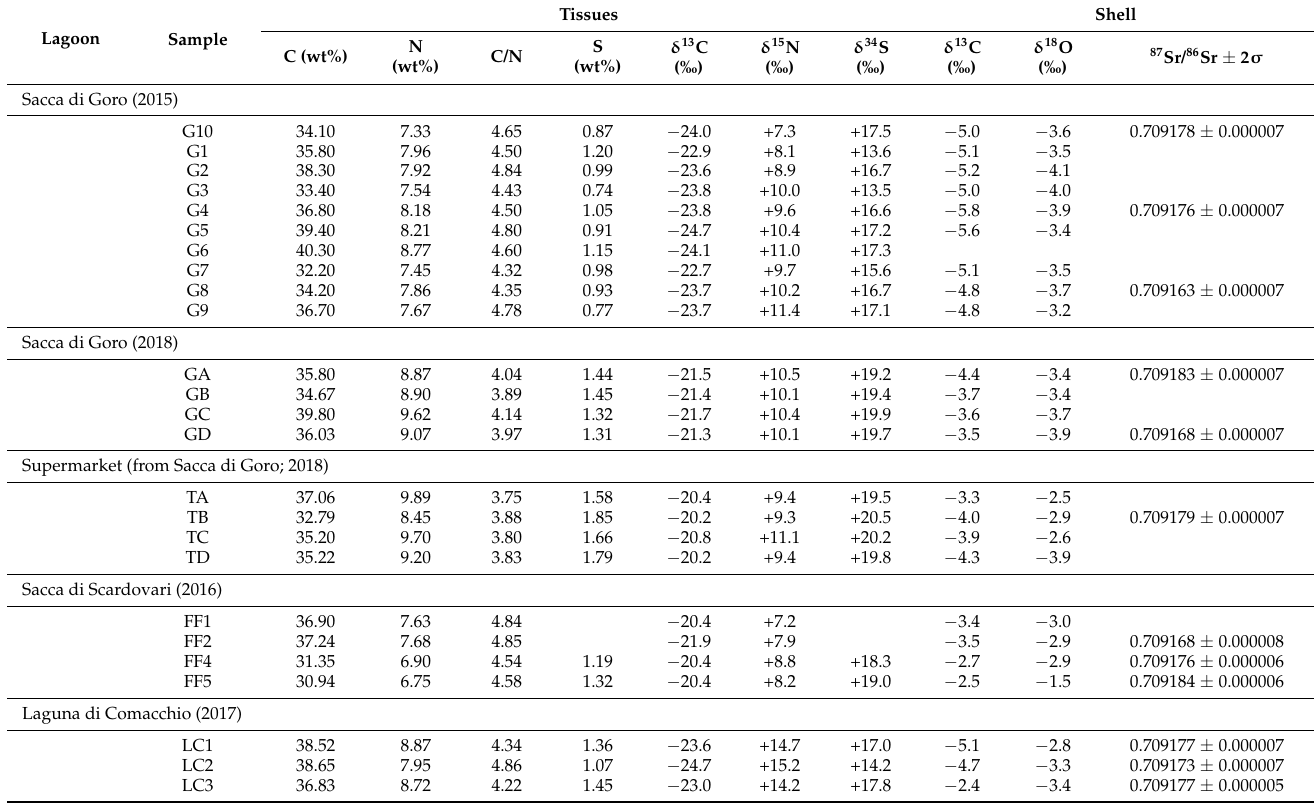
Table 1. Elemental and isotopic compositions of carbon (C), nitrogen (N), sulfur (S), oxygen (O), and strontium isotope composition ( 87 Sr/ 86 Sr) in tissues and shells of manila clam samples collected on-site from northern Adriatic lagoons and bought at the local supermarket. Analytical uncertainties for 87 Sr/ 86 Sr analyses are also